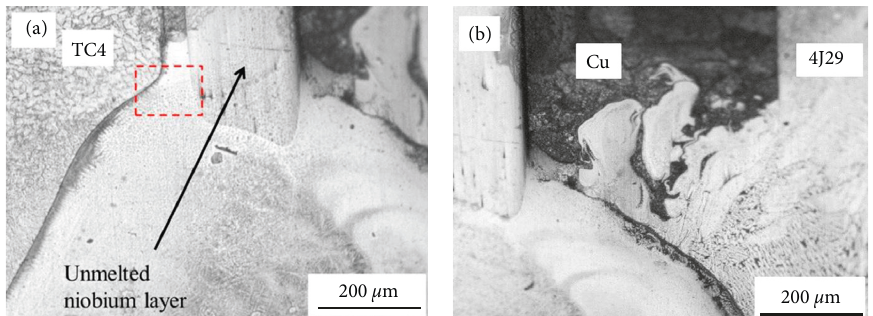
Figure 3: The cross section of the weld of welded joint EBW-1: (a) the titanium alloy side; (b) the kovar alloy side.